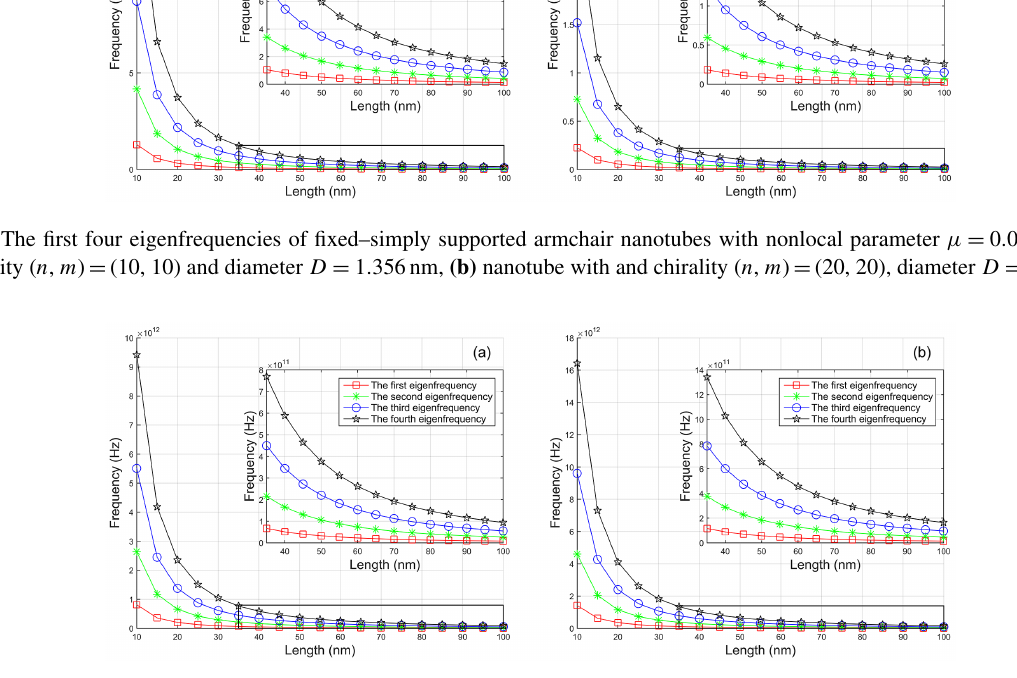
Figure 7. The first four eigenfrequencies of fixed–simply supported armchair nanotubes with nonlocal parameter µ = 0 . 1, (a) nanotube with chirality ( n , m ) = (10, 10) and diameter D = 1 . 356nm, (b) nanotube with and chirality ( n , m ) = (20, 20), diameter D = 2 . 712nm.